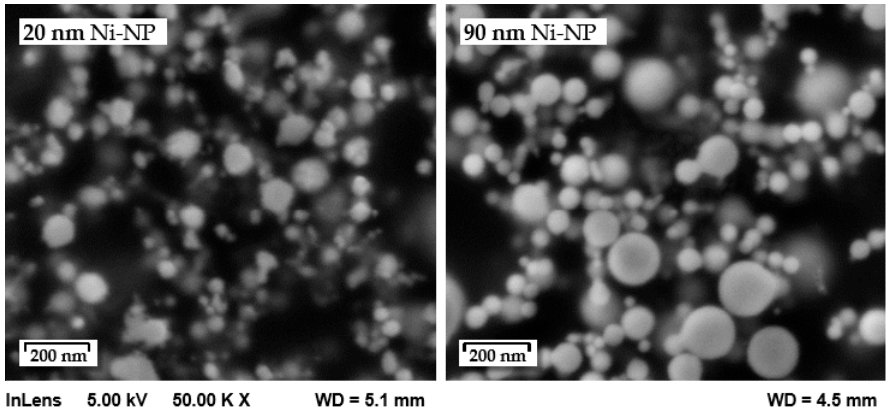
Figure 1. As-delivered nickel nanoparticles used for the preparation of Ni nanopastes.